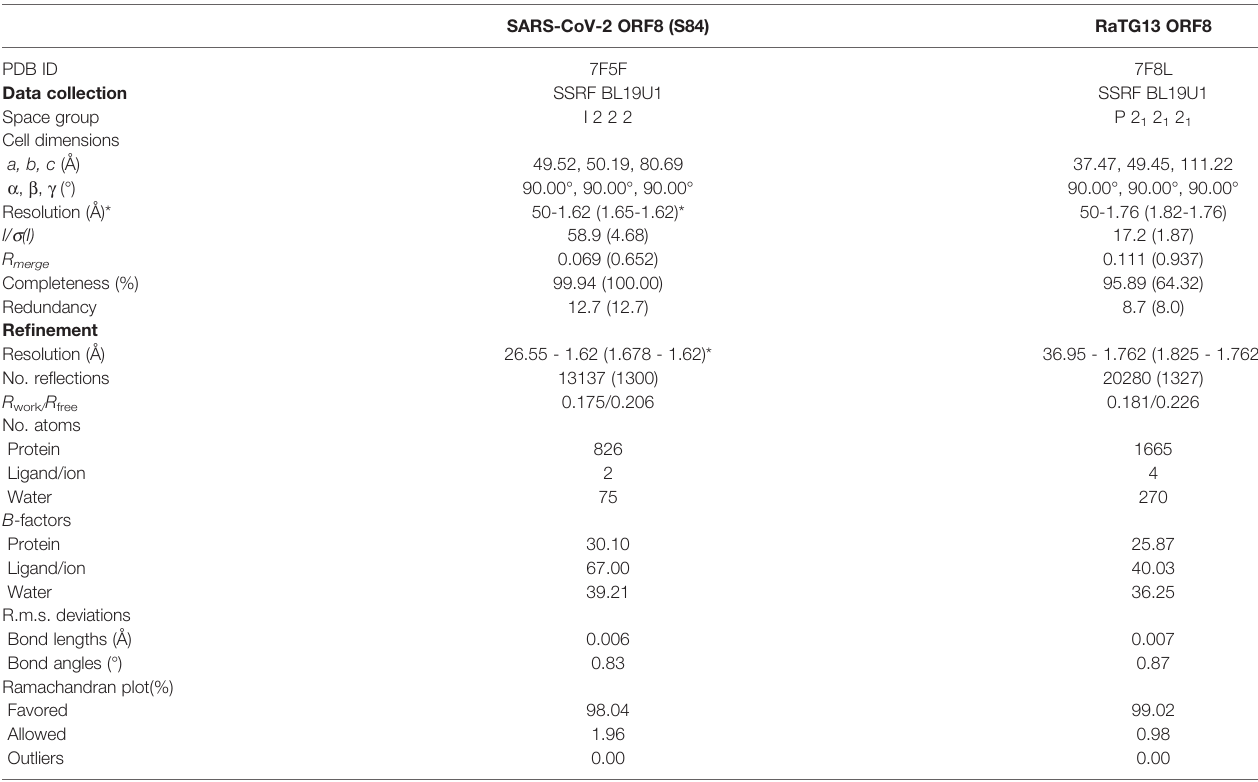
TABLE 1 | Data collection and re fi nement